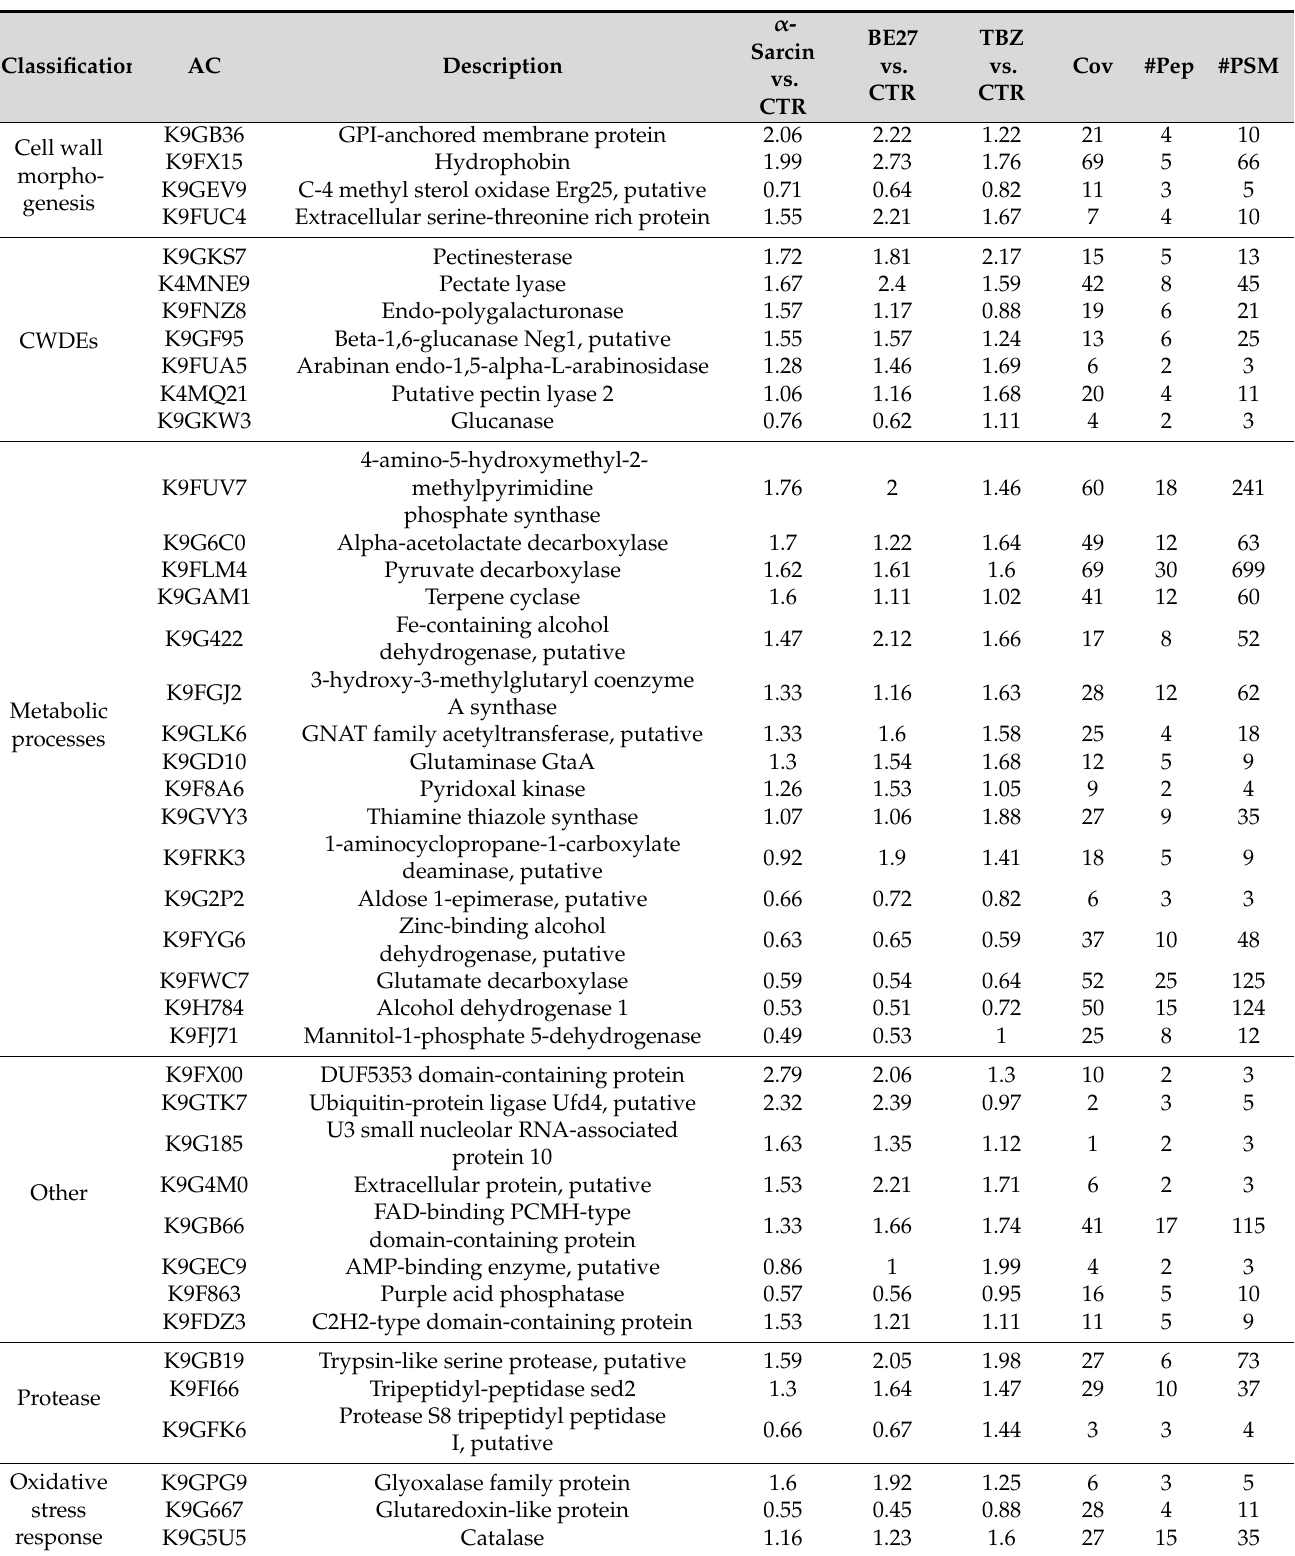
Table 1. Proteins differentially regulated identified by high-resolution nanoLC-MS/MS in P. digitatum following treatments with the toxins α -sarcin and beetin 27 (BE27) and the fungicide thiabendazole (TBZ). CTR, Untreated samples. A total of 49 out of 1709 proteins were found to be differentially expressed (0.6 ≥ FC ≥ 1.5) in treated samples with respect to untreated